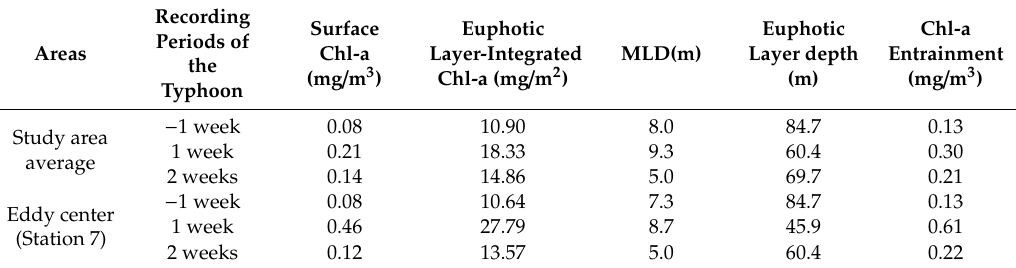
Table 1. The surface and column-integrated Chlorophyll a concentration, the MLD, the euphotic layer depth (ELD), and the Chl-a entrainment before and after the